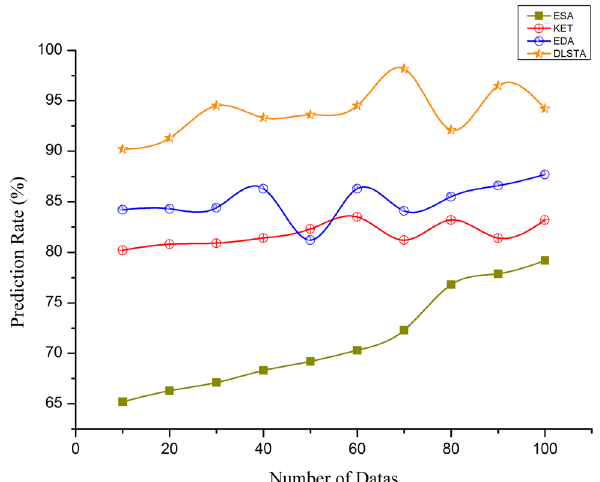
Figure 6: The prediction rate of